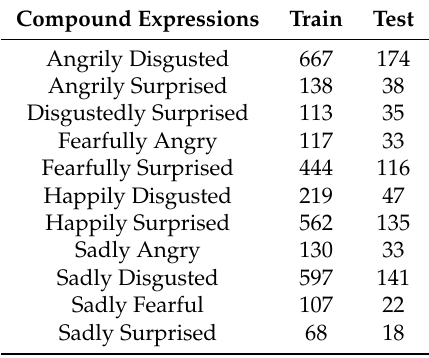
Table 3. Distribution of various samples in RAF